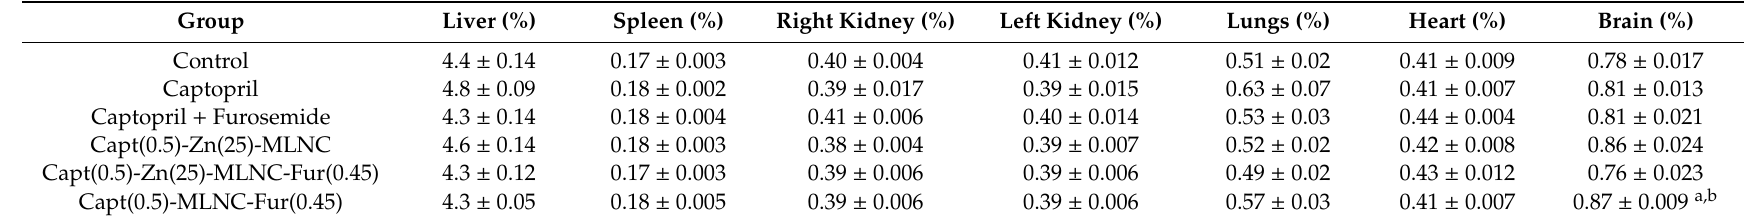
Table 3. Relative organs mass of spontaneously hypertensive rats (SHR) after 5 days of oral treatment (8 mL kg − 1 ) with solutions or formulations ( n = 6). Values are expressed as mean ± SEM. Data were analyzed by ANOVA /